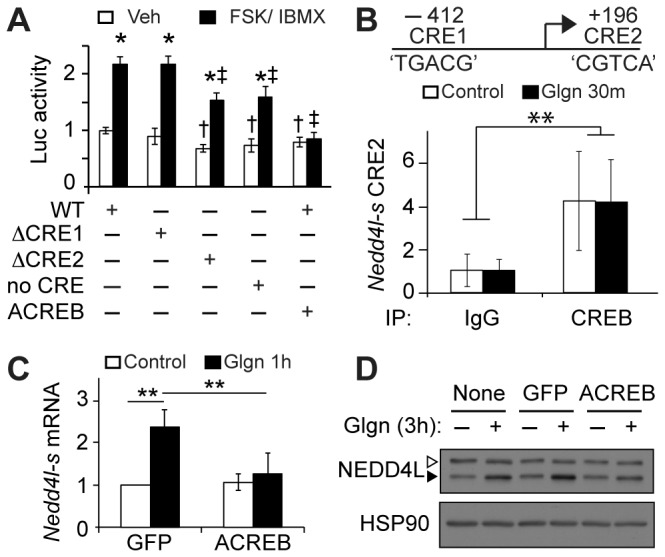

Nedd4l-short is a CREB target gene.(A) Nedd4l-short luciferase reporter activity in HEK293T cells treated with FSK/ IBMX (6 h). Wild type (WT) Nedd4l-short luciferase reporter compared with individual CRE site mutations (ΔCRE1 or ΔCRE2) or both CREs deleted (no CRE). Effect of co-transfected ACREB is shown. *p<0.01 between veh and FSK/ IBMX treated; ‡p<0.01 to FSK/ IBMX-treated WT; †p<0.01 to veh-treated WT (n=6 replicates shown, representative of three independent experiments). See Figure S2A, B for empty vector control and luciferase data expressed in A.U. (B) Top, predicted CREB binding sites (CRE1: -412 ‘TGACG’; CRE2: +196 ‘CGTCA’) in mouse Nedd4l-short promoter. Bottom, chromatin immunoprecipitation from primary mouse hepatocytes treated without or with glucagon (100nM, 30 min) using non-specific IgG (IgG) or anti-CREB IgG. Recovery of Nedd4l-short genomic DNA containing CRE2 was quantified in chromatin immunoprecipitates, normalized to the input and expressed as mean fold enrichment ± stdev over matched IgG controls among 3 replicates. **, p<0.01 comparing all IgG and all CREB samples. See Figure S2C for Pepck and Gapdh controls. (n=3 independent experiments) (C and D) Nedd4l-short mRNA expression (C, n=4, **p< 0.01) and NEDD4L protein levels (D, n=3) in primary hepatocytes infected with Ad-GFP or Ad-ACREB and treated with glucagon (100nM). Filled arrowheads, NEDD4L-short; open arrowheads, NEDD4L-long. See Figure S2F for quantification of western blots.